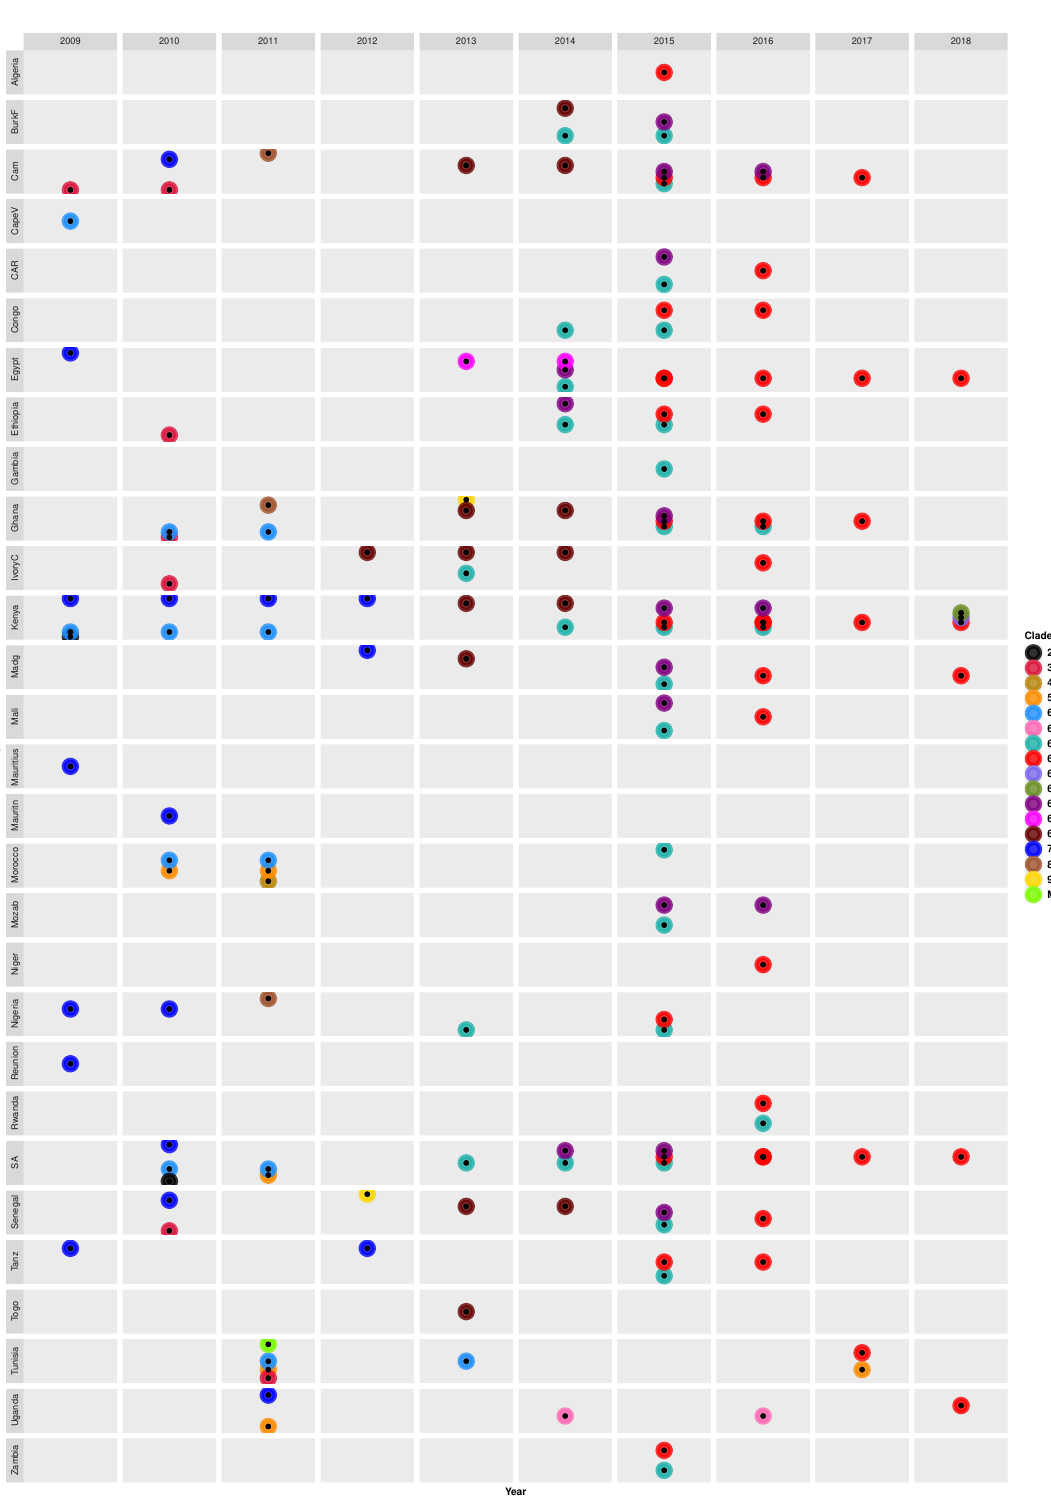
Figure 4. Temporal and geographical distribution of genetic clades of pandemic H1N1pdm09 (2009–2010) and seasonal H1N1pdm09 (2011 onwards) virus strains that circulated in Africa be- tween 2009 and 2018. Abbreviations: Burkina Faso (BurkF), Cameroon (Cam), Cape Verde (CapeV), Central African Republic (CAR), Ivory Coast (IvoryC), Madagascar (Madg), Mauritania (Mauritn), Mozambique (Mozab), South Africa (SA), Tanzania (Tanz), and A/Madrid/SO8171/2010(H1N1)-like clade (Madrid). Details on the characteristic genomic markers (amino acid substitutions in the HA1 proteins) for each clade are described in Table